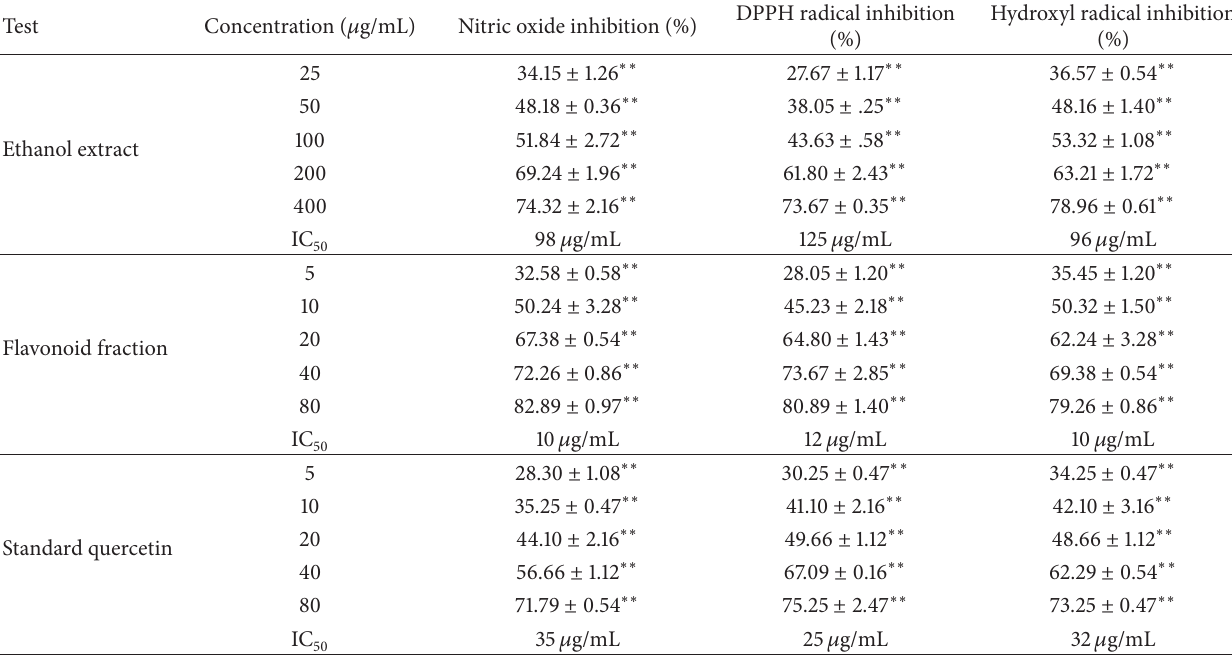
Table 2: Free radicals scavenging property of ethanolic extract and isolated flavonoid fraction of Cissus quadrangularis